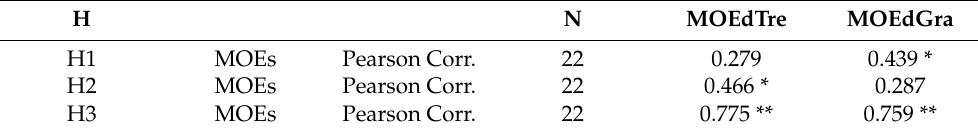
Table 4. Two-tailed linear correlation divided by the three designated heights between the static elastic modulus and the dynamic elastic modulus obtained with TreeSonic and Resonance Log Grader devices. H N MOEdTre MOEdGra H1 MOEs Pearson Corr. 22 0.279 0.439 * H2 MOEs Pearson Corr. 22 0.466 * 0.287 H3 MOEs Pearson Corr. 22 0.775 ** 0.759